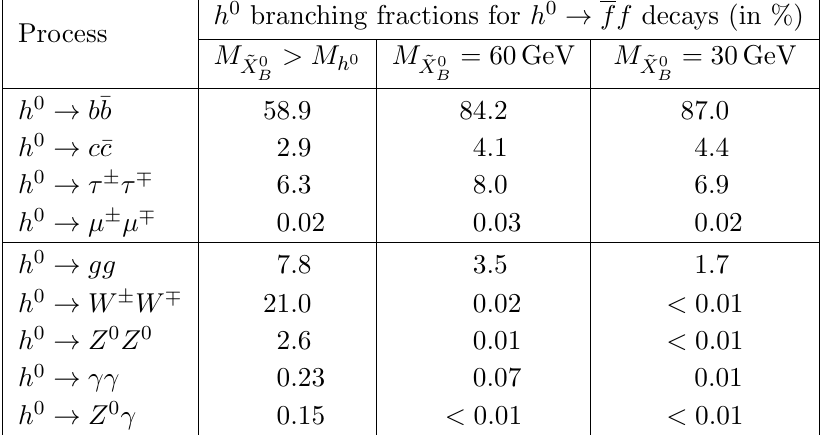
Table 3. Branching fractions for decays of the virtual Higgs boson for the h 0 ! ff process for several values of the ~ X 0 mass. These values are adapted from the Higgs branching fractions B presented as a function of mass, published by the CERN LHC Higgs Yellow Report [63]. Decay modes which contribute < 0 : 01% for all values of the Bino LSP mass are